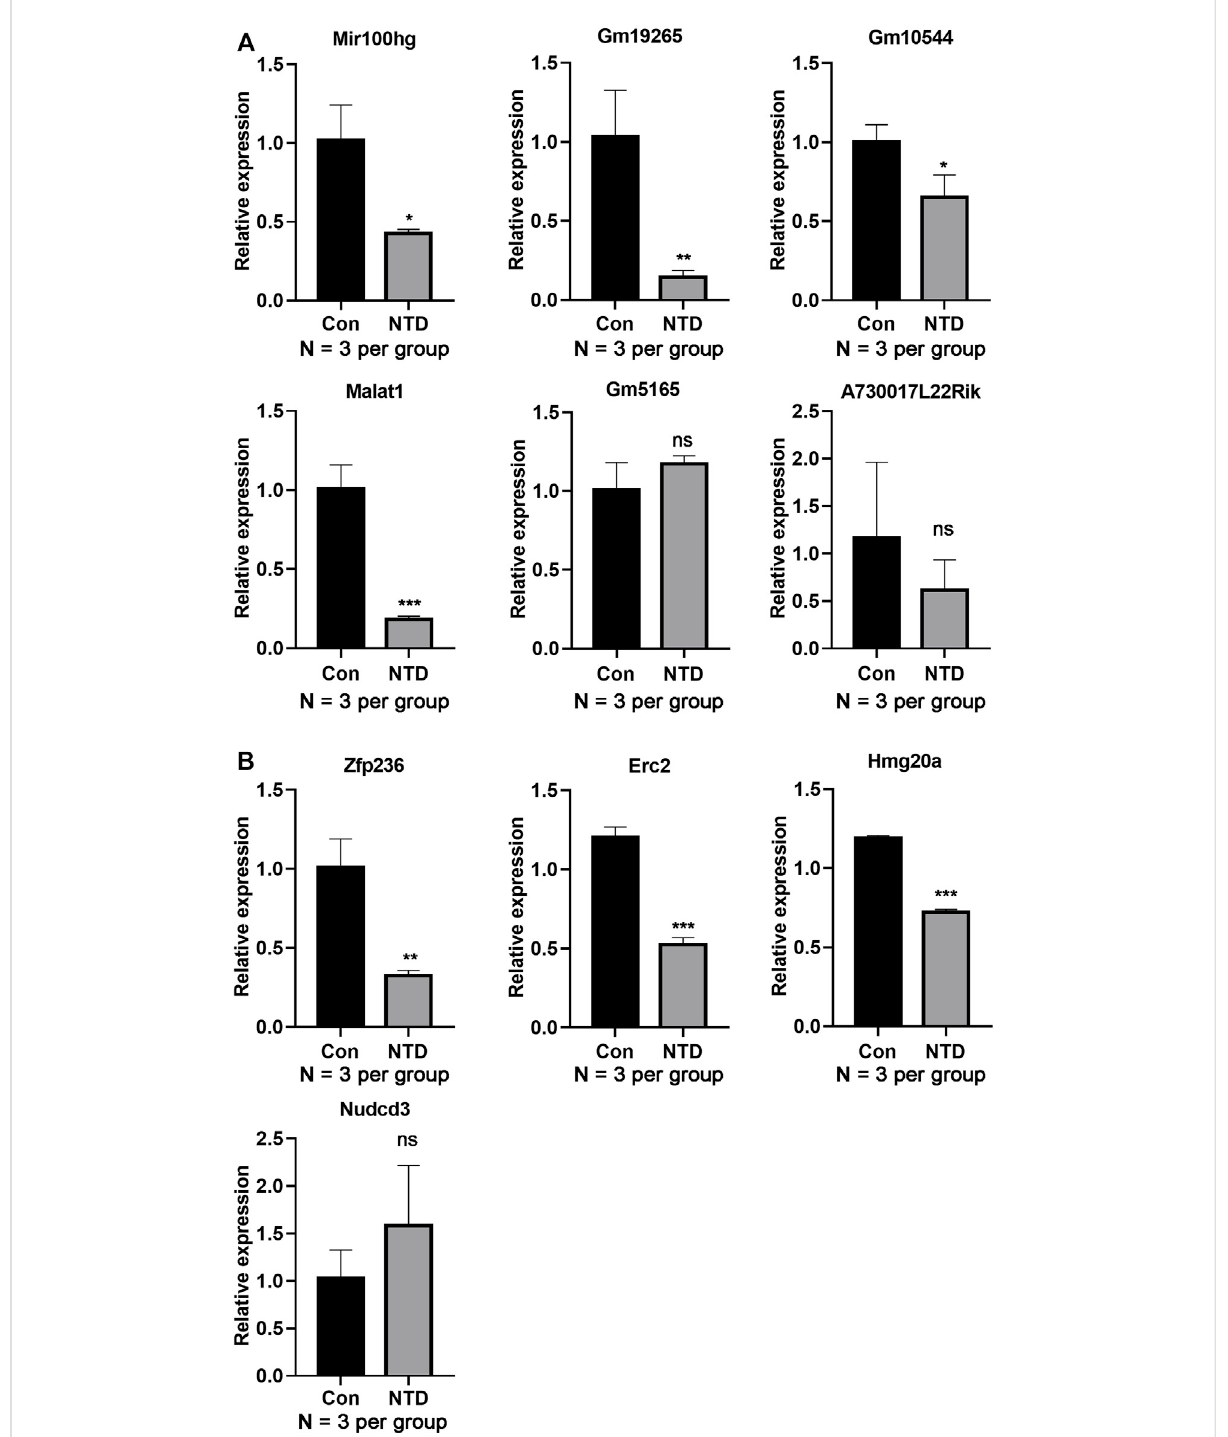
FIGURE 5 qRT-PCRassayveri fi edthelncRNAandgeneexpressionlevelsinthebraintissuesofNTDandcontrolembryos. (A) ExpressionlevelsoflncRNAs, such as Mir100hg, Gm19265, Gm10544, and Malat1 (N = 3 per group). (B) Expression levels of genes, such as Zfp236 , Erc2 , and Hmg20a (N = 3 per group). Compared to control group, * p < 0.05, ** p < 0.01, and *** p <